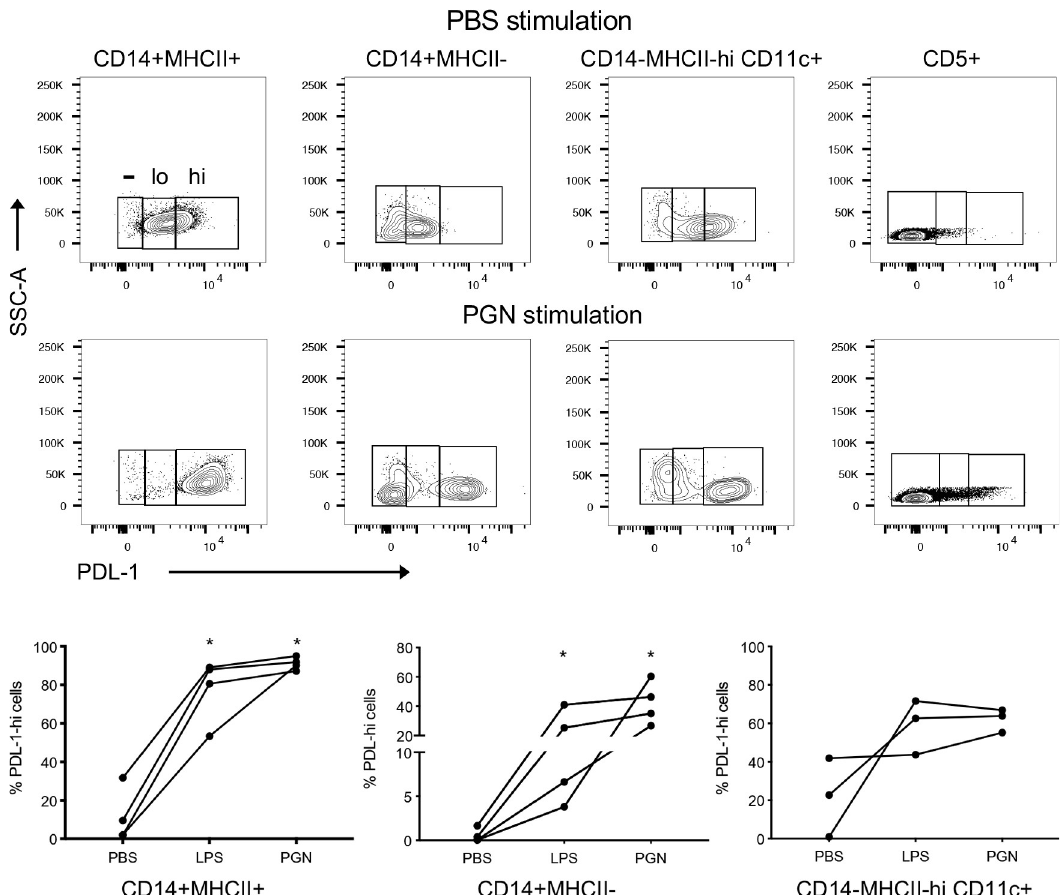
Fig 6. Detection of PD-L1 expression on peripheral blood immune cells by anti-canine PD-L1 antibody JC071. PBMCs from healthy donor dogs were stimulated with PBS, LPS, or PGN for 3 hours followed by overnight incubation. A representative staining of PBMC immune cell subsets for PD-L1 expression by flow cytometry using antibody JC071 from a healthy canine donor is shown before and after stimulation with PGN (A). Frequencies of monocyte subsets (MHCII + CD14 + and MHCII - CD14 + ) from four canine donors and MHCII hi CD14 - CD11c + dendritic cells from three donors (B). A pair-wise comparison between stimulation conditions by the Mann-Whitney test was used for statistical analysis. Statistically significant differences are indicated by an